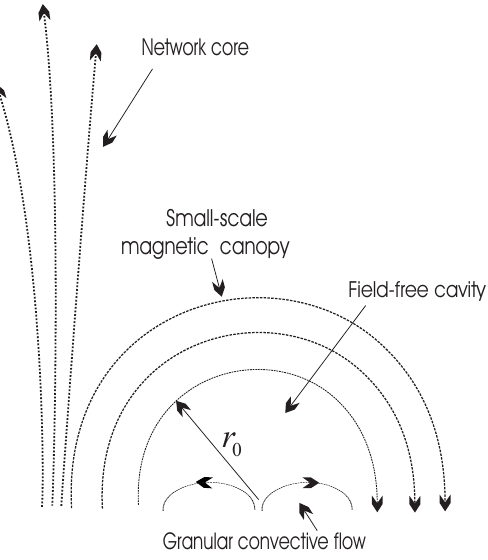
Fig. 1. Schematic picture of the magnetic canopy overlying a field- free